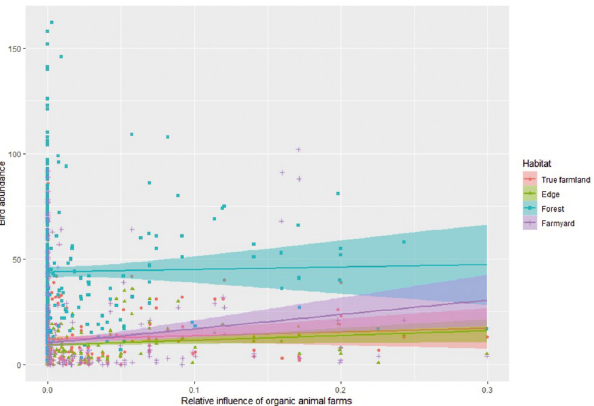
Fig 4. Effects of organic animal farms on bird abundance by habitat class. The differential effect of relative influence of organic animal farms (averaged within a 300m radius from each transect line, see Fig 1b) on the summed abundance of birds separated by their main habitat (true farmland, farmyard, edge and forest species). Values are based on the original untransformed data. The results of the interaction between relative influence of organic animal farms and birds habitat are presented in Table D in S1 File.